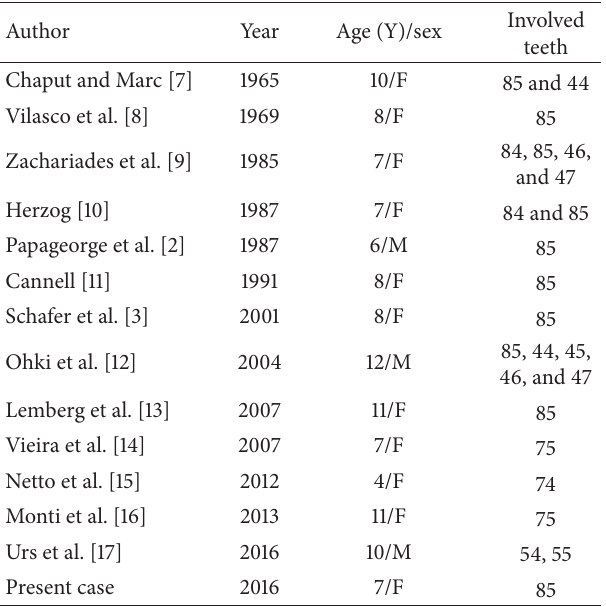
Table 1: Reported cases of cementoblastoma associated with pri- mary